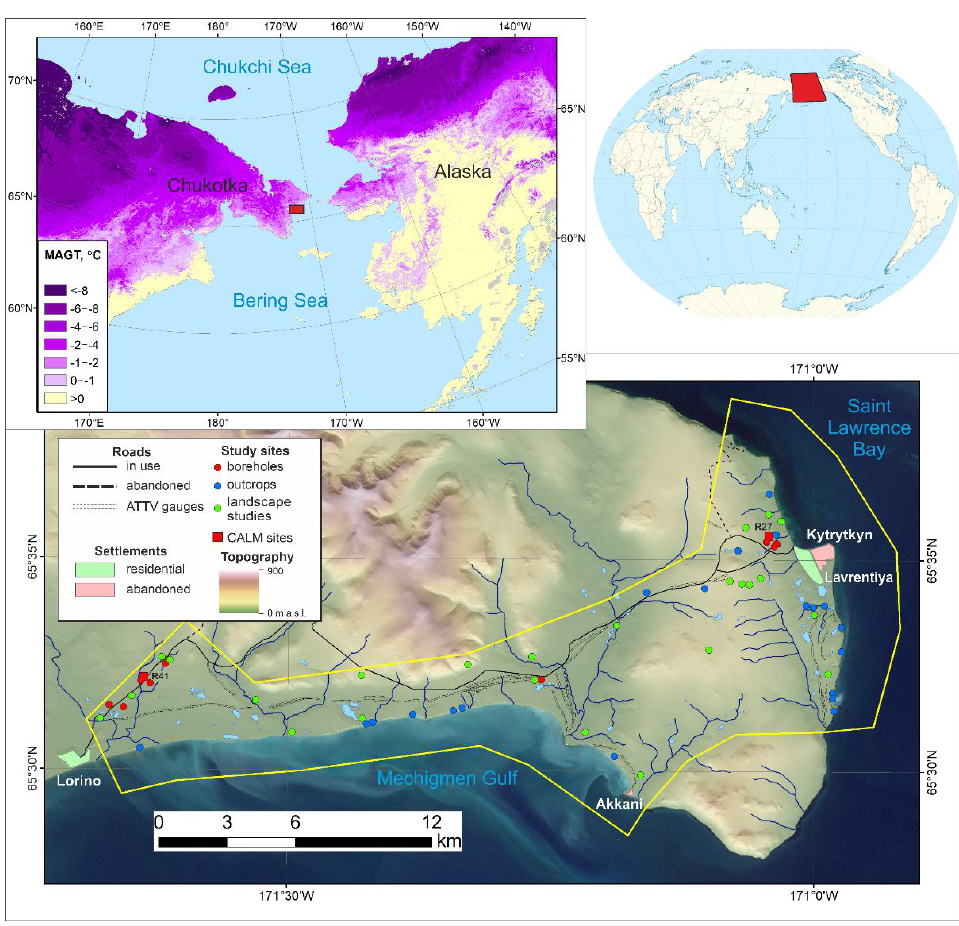
Figure 1. Study area. Mean annual ground temperature (MAGT) from [48] and elevation data from ArcticDEM v.7 [49].